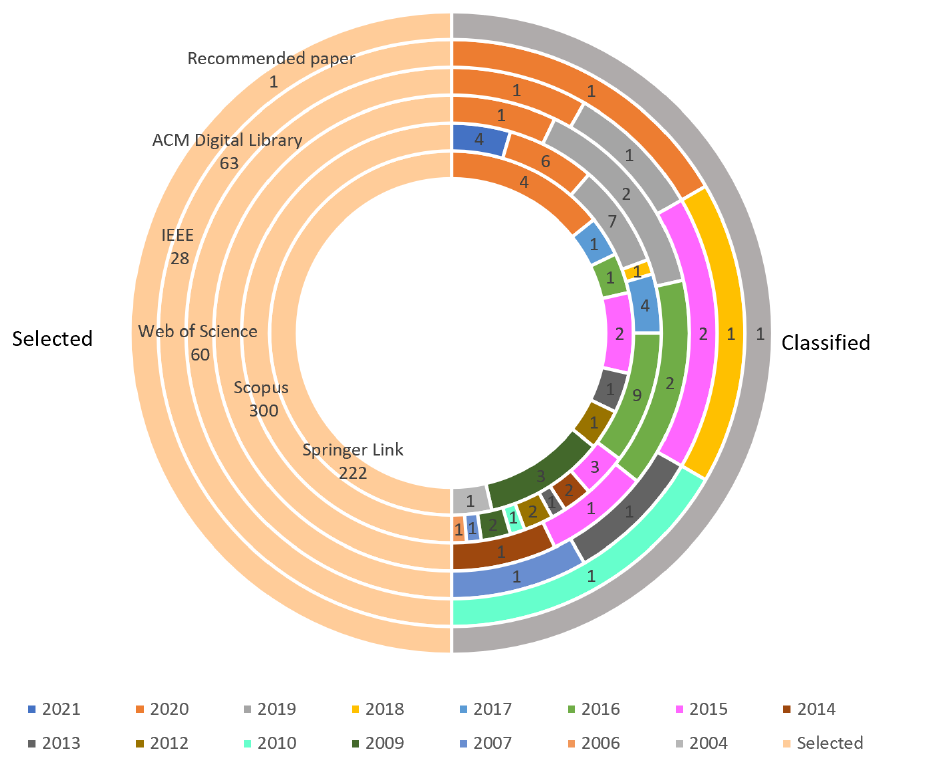
Figure 3. Selected and classified papers per source and year. Source: